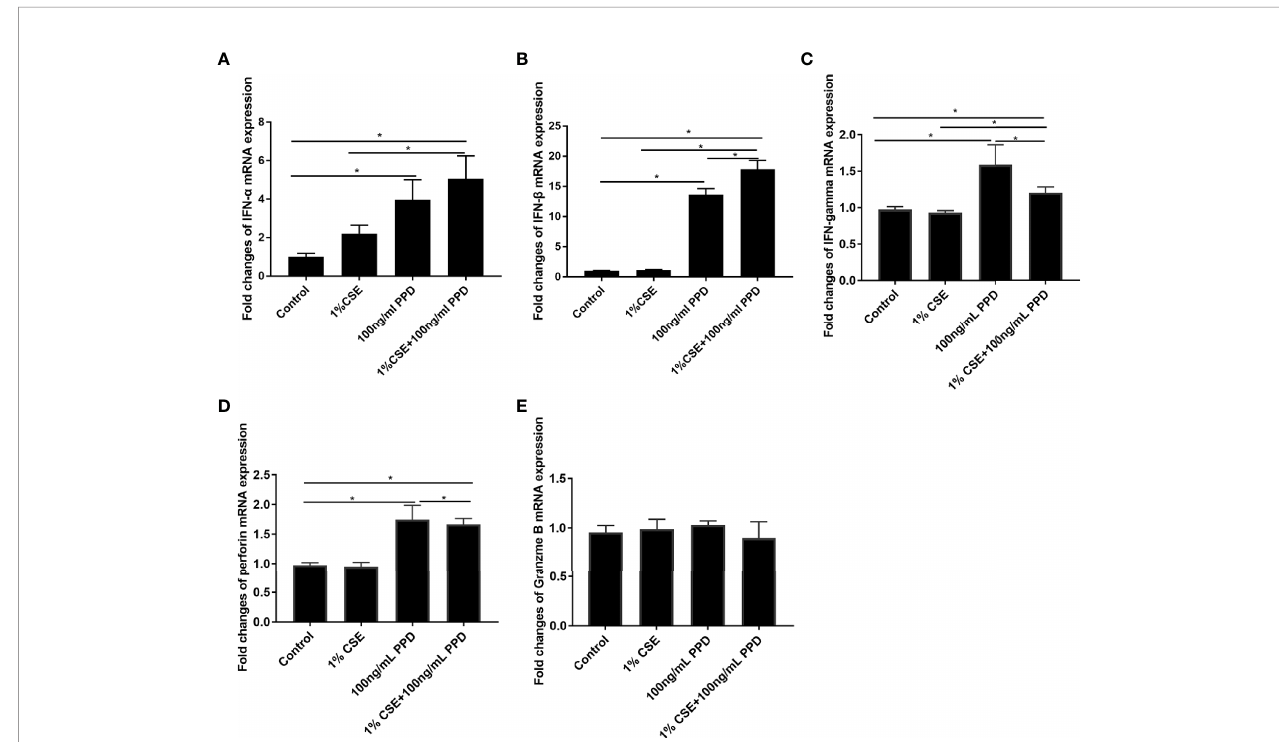
FIGURE 3 | CSE and PPD coexposure induced proin fl ammatory cytokine production in NK-92 cells. NK-92 cells were stimulated with 1% CSE and/or 100 ng/ml PPD accordingly for another 24 h The speci fi c grouping is as follows: control (control group), 1% CSE (CSE group), 100 ng/ml PPD (PPD group), 1% CSE+100 ng/ ml PPD (CSE- and PPD-coexposed group). mRNA expressions of IFN- a (A) , IFN- b (B) , IFN-gamma (C) , perforin (D) , and granzyme B (E) were assessed by qRT- PCR. n ≥ 3 independent experiments. One-way analysis of variance (ANOVA) with Bonferroni or Dunnett ’ s T3 posttest analysis was performed for comparisons between multiple groups. * p <